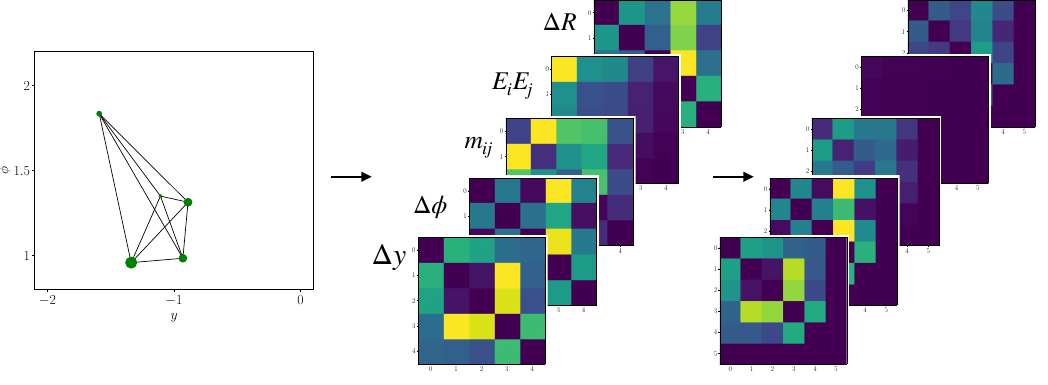
Figure 3. For a graph we find five weighted adjacency matrices from it, each one capturing features of the graph nodes. These five are then scaled and padded, giving the final matrices on the right. These can be embedded and used as input to classification